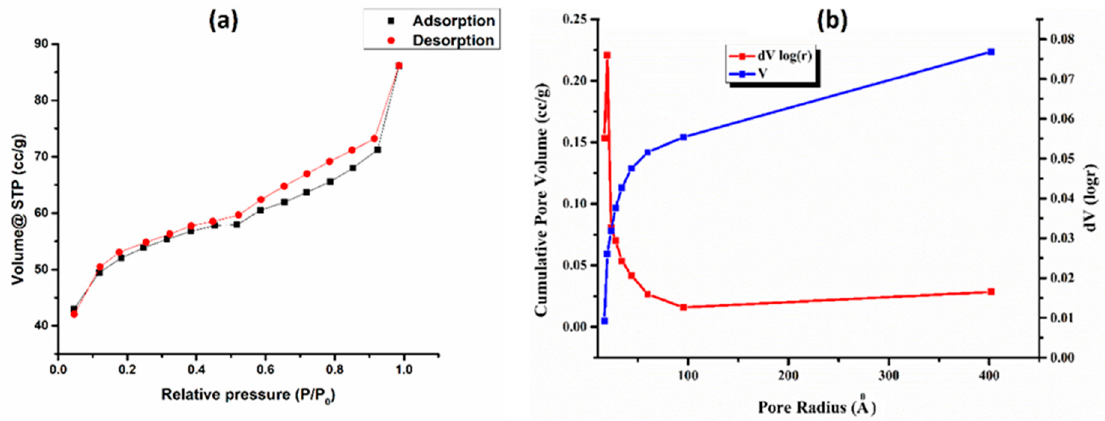
Figure 4. ( a ) N 2 adsorption–desorption isotherms; ( b ) pore size distribution of